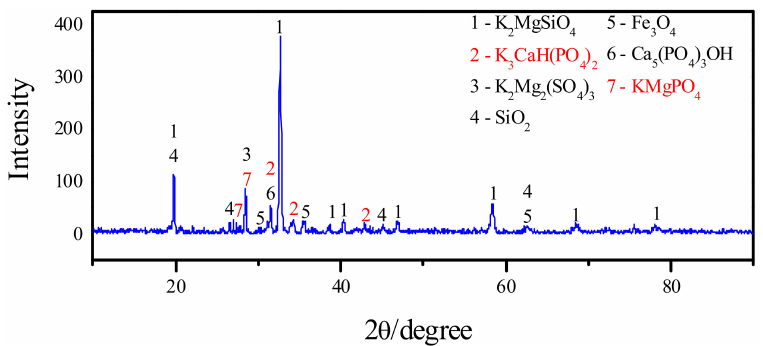
Figure 10. The XRD curve of SSA modified by 40% K 2 CO 3 calcination in air at 950 ◦